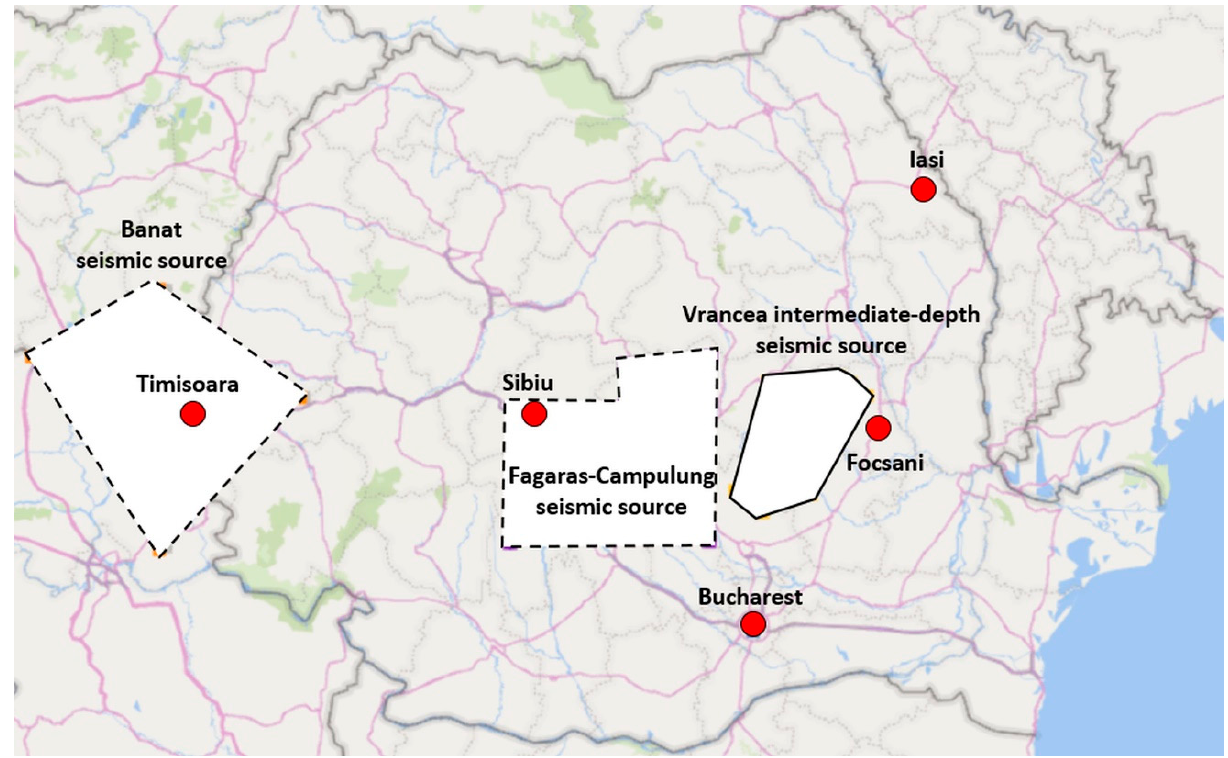
Figure 4. Positions of the five analyzed sites and contours of the three seismic sources. The contribution of each magnitude range on the seismic hazard level for the peak ground acceleration (PGA) with a mean return period of 475 years (probability of exceedance of 10% in 50 years) is shown in Table 2 based on the results from [9]. Table 2. Seismic hazard disaggregation (peak ground acceleration with a mean return period of 475 years) as a function of the earthquake magnitude for five cities in Romania [9]